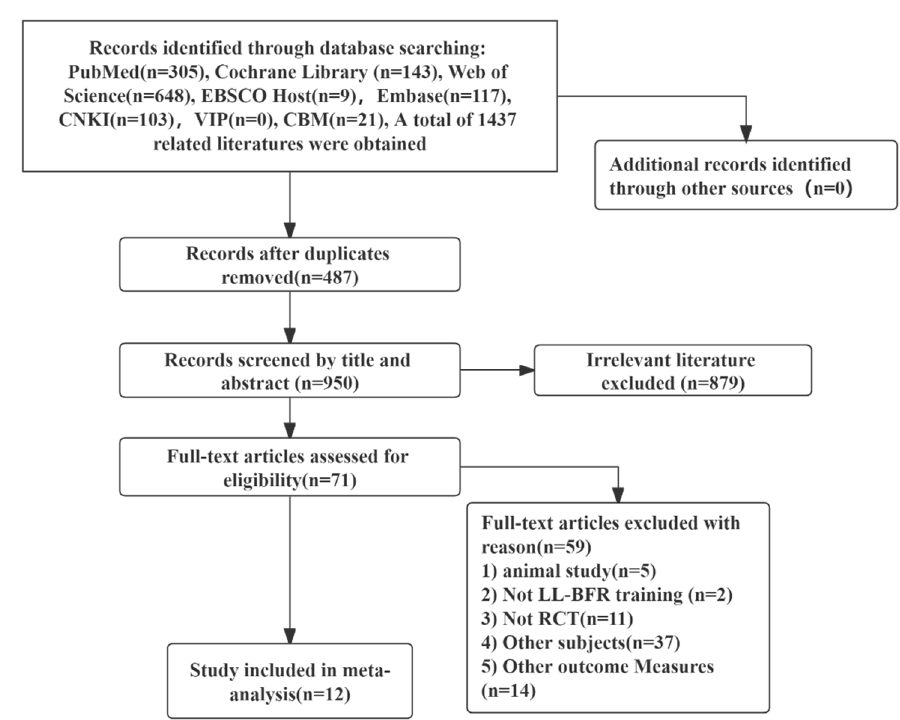
Figure 1. PRISMA flow diagram of the study selection process.